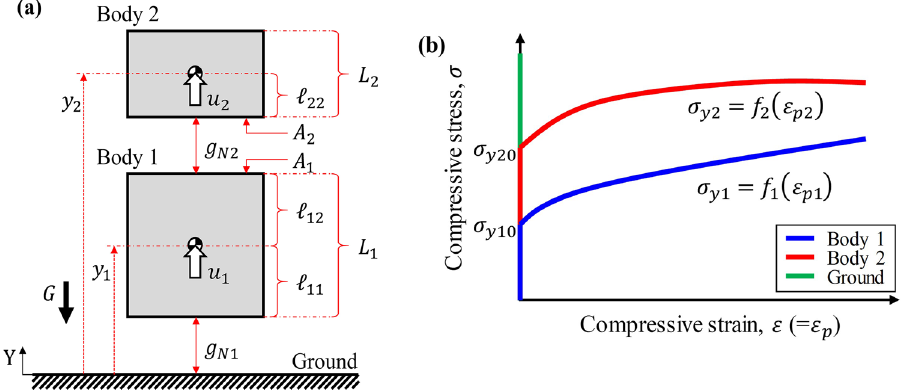
Fig. 4 a Model composed of basic elements; b Model of